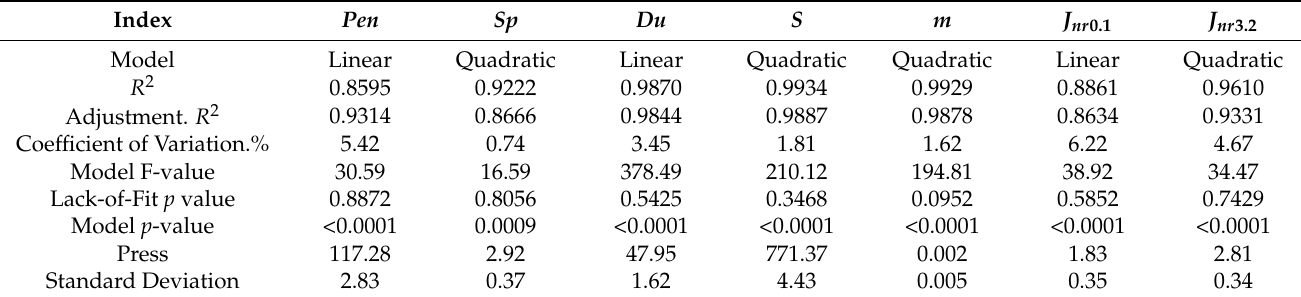
Table 5. Variance analysis results of the composite modified asphalt (CMA) performance.